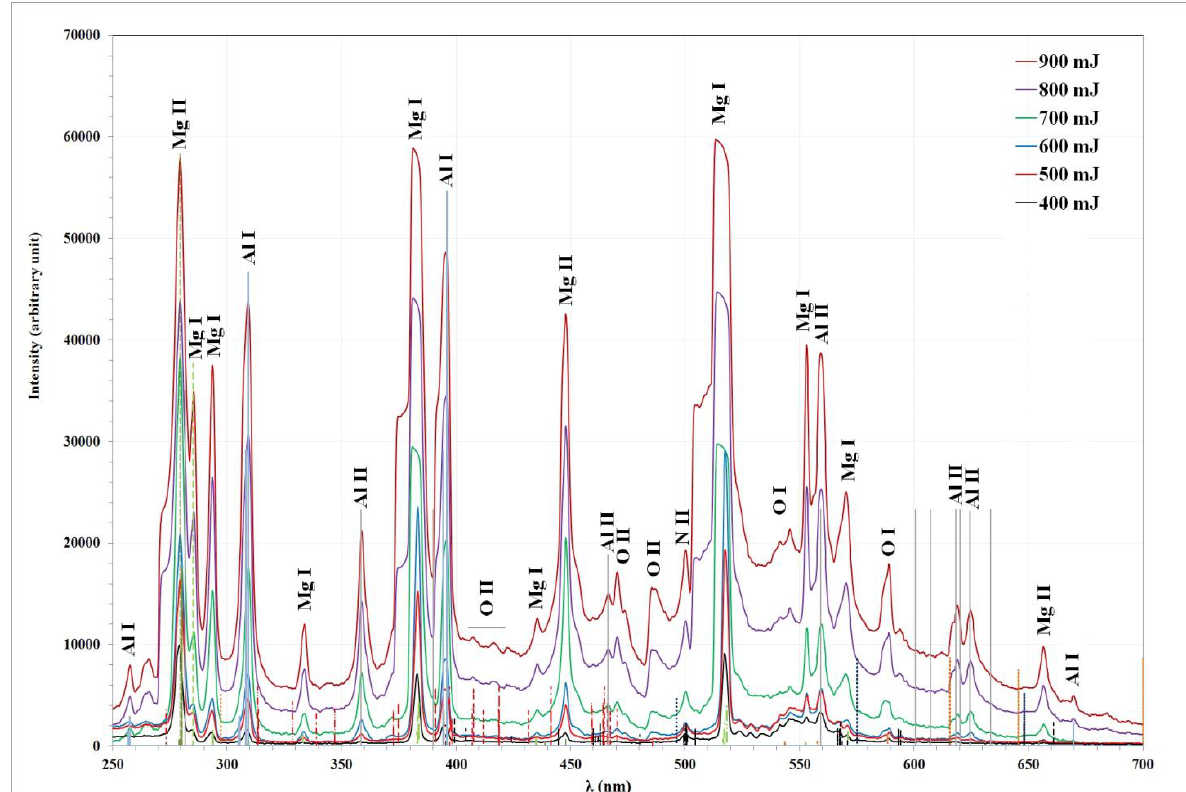
Fig. 4: Plasma emission spectra induced by 1064 nm laser, with different laser energies for magnesium and aluminum powder in